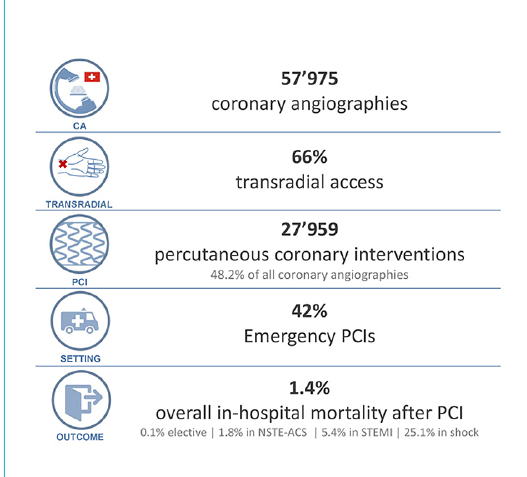
artery stenosis was quantified by fractional flow reserve (42.3%), instantaneous wave-free ratio (28.7%), intravas- cular ultrasound (10.0%) or optical coherence tomography (19.0%). With a total of 554 cases (1%), left ventricular as- sist devices were rarely needed (table 5).